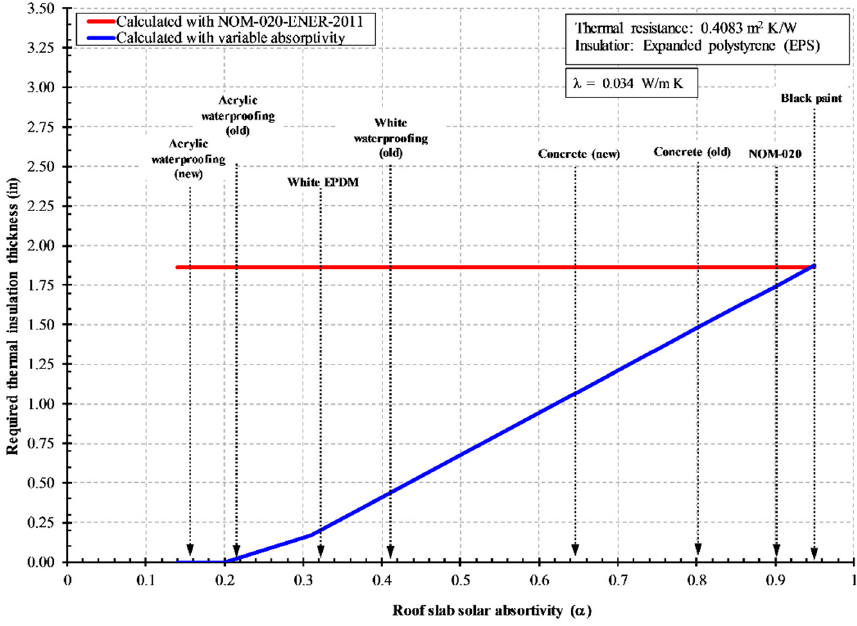
Figure 9. Roof insulation required to comply with NOM-020 in Monterrey, N.L.